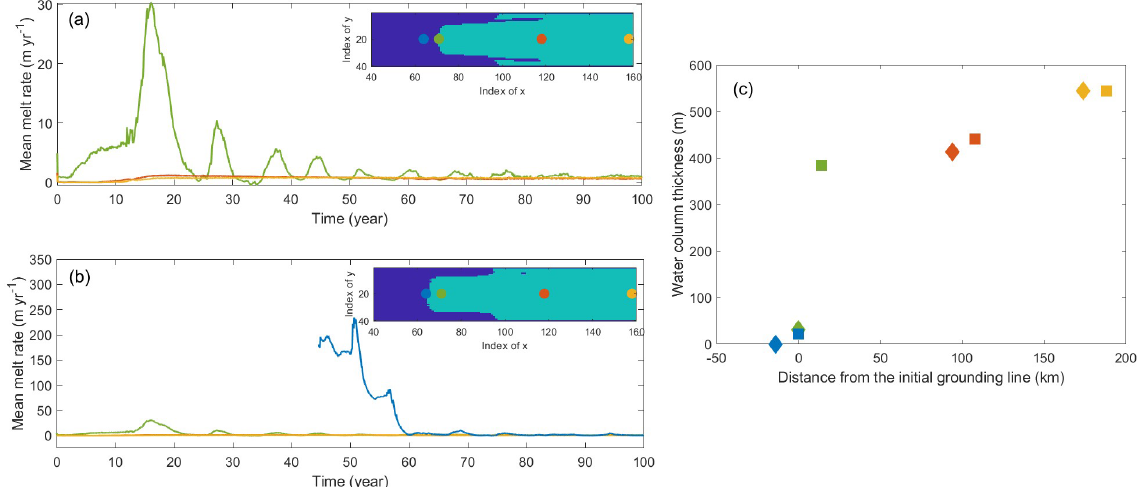
Figure A3. Changes of melt rate of ocean cells at different locations along the center line of domain (yellow line in Fig. 2). The locations of ocean cells are shown in the inset panels with background image indicating the grounded mask of (a) year 0 and (b) year 44. Green and blue dots are located on the grounding line of year 0 and year 44, respectively. The distance of those points from the initial grounding line and the water column thickness are shown in (c) . The diamond and square points represent the points in year 0 and 44, respectively.